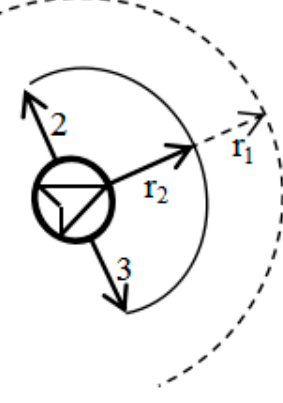
Figure 6. Detection model.